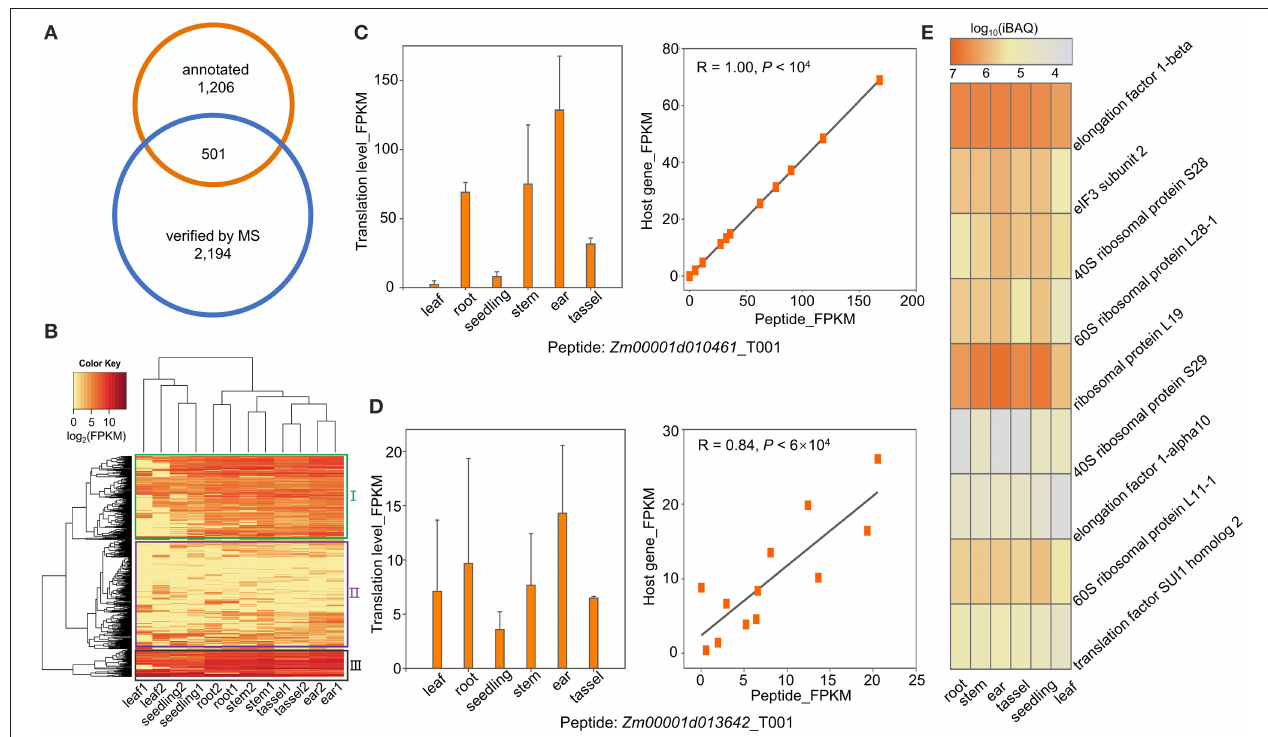
FIGURE 4 | Functional annotation of sPeptides in maize. (A) Gene-derived sPeptides were identified by the intersection between annotated genes and sPeptides in this study. (B) Gene-derived sPeptides classified different tissues and clustered them into three groups based on their expression patterns. (C,D) Translatome abundance variation of sPeptides Zm00001d010461_T001 (C) and Zm00001d013642_T001 (D) across different tissues shows a high correlation with that of their parental canonical protein-coding gene. (E) Proteome abundance of sPeptides across different tissues from Group